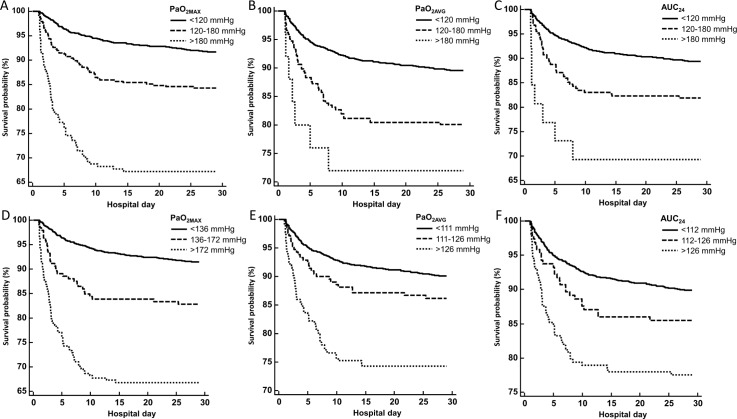
Survival analysis according to hyperoxia metrics.At the cutoffs of 120 and 180 mmHg, A) patients with highest partial pressure of oxygen (PaO2MAX) between 120 and 180 mmHg, and those with PaO2MAX over 180 mmHg were associated with higher 28-day in-hospital mortality compared with normoxic patients (PaO2MAX 60-120mmHg) (log rank test p<0.01). B) Average partial pressure of oxygen (PaO2AVG) and C) area under curve over the first 24 hours (AUC24) reflecting cumulative oxygen exposure were also shown to be associated with higher mortality (log rank test p<0.01 both). At the cutoffs of 80th and 90th percentile in each hyperoxia metrics, D) PaO2MAX, E) PaO2AVG, and F) AUC24 showed consistent associations with higher mortality, and all were statistically significant (log rank test p<0.01).